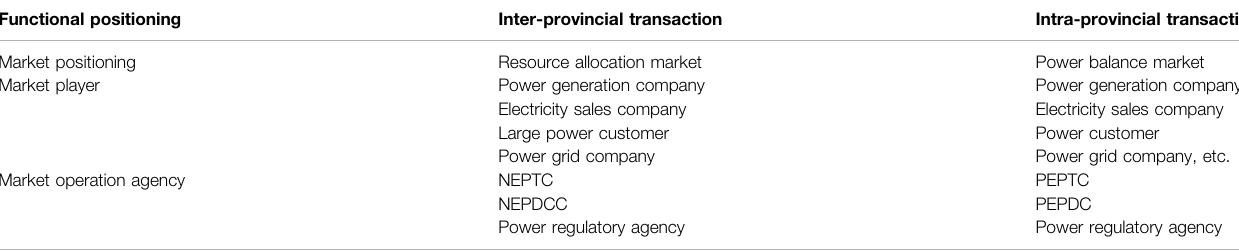
TABLE 1 | Functional positioning of a two-tier electricity market. Functional positioning